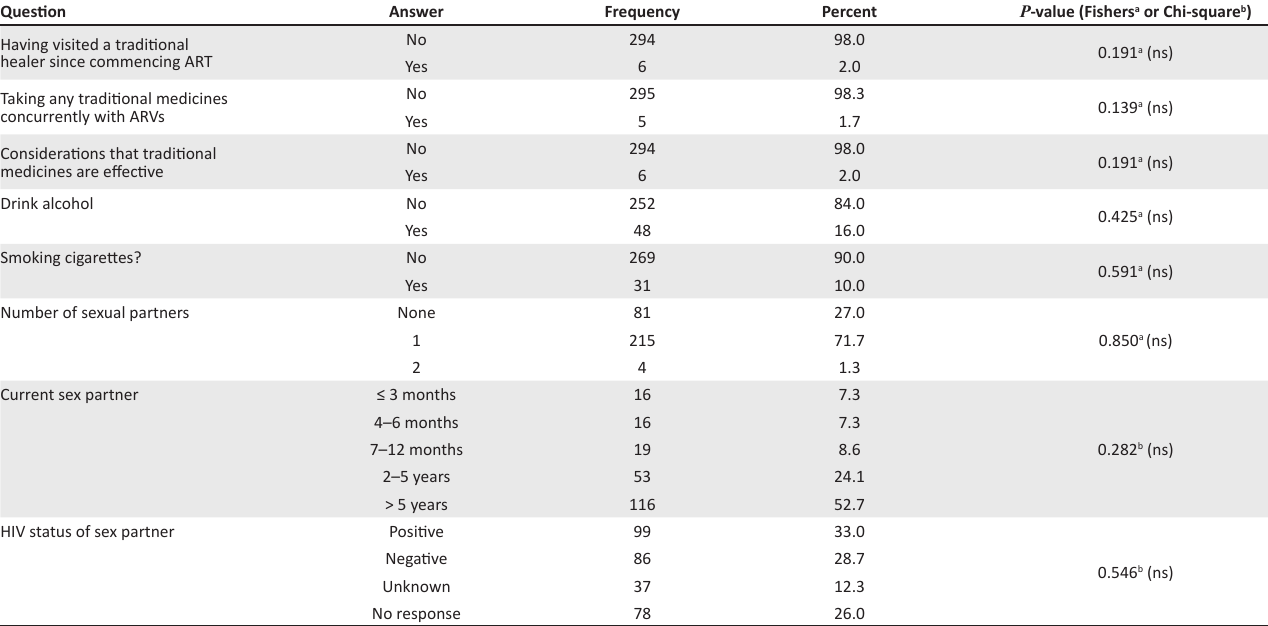
TABLE 2: Social and cultural factors influencing antiretroviral therapy adherence